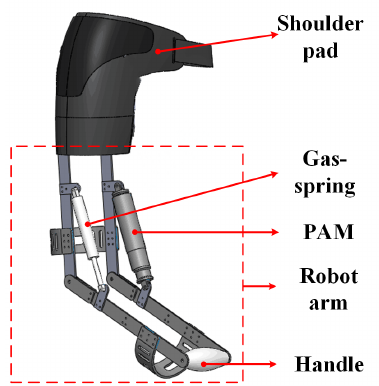
Figure 1. One-DOF upper-limb